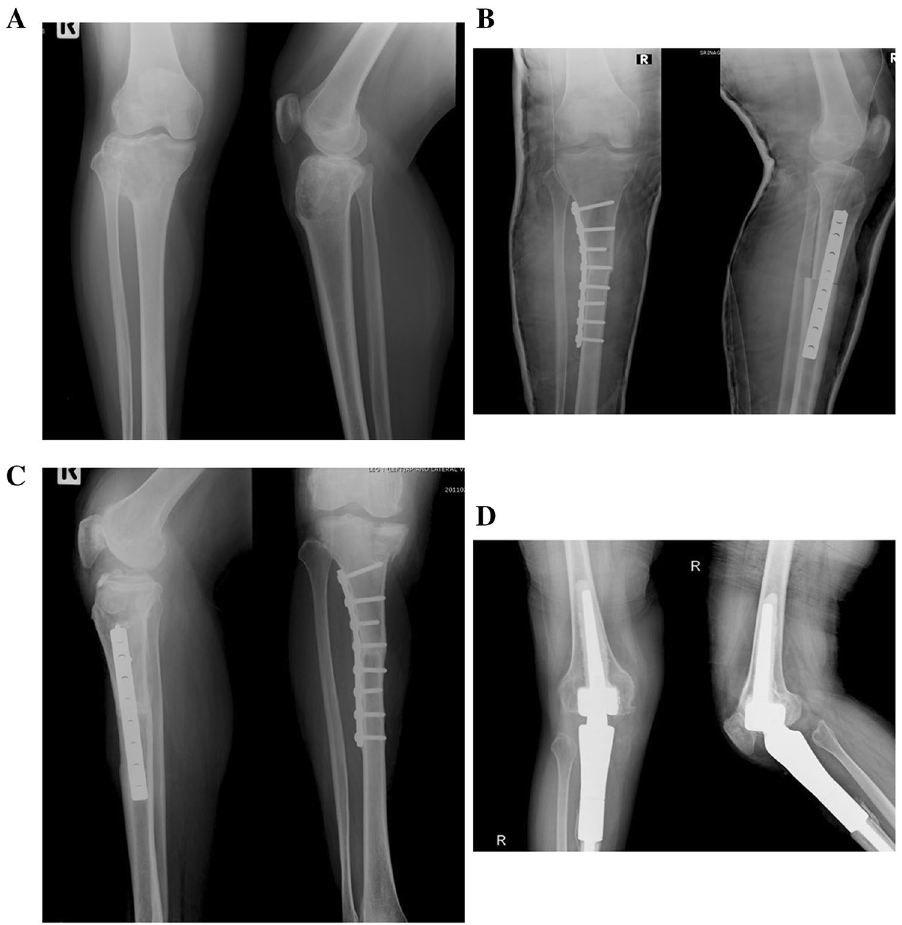
Figure 2. A 33-year-old female with osteosarcoma of the right proximal tibia. ( A ) Pre-operative anteroposterior and lateral radiograph. ( B ) After adjuvant chemotherapy, wide resection and reconstruction with proximal tibia allograft were performed. ( C ) Fracture of allograft (medial tibial condyle) occurred 5 years after reconstruction. ( D ) Revision surgery with proximal tibia endoprosthesis successfully